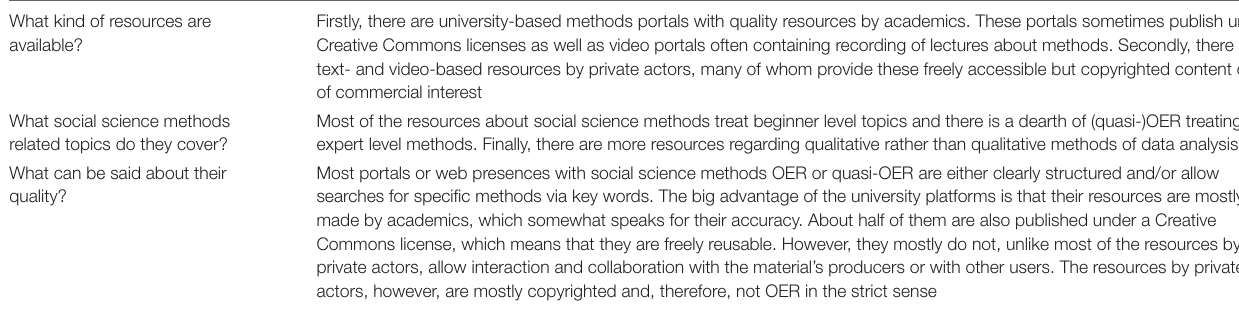
TABLE 2 | Research questions and summarized